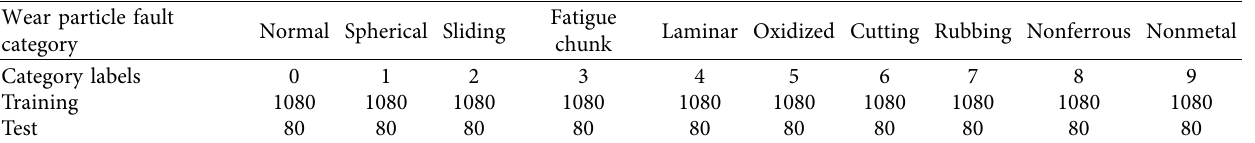
Figure 9: Feature visualization via t-SNE. Last hidden fully connected layer representation for the test samples in four models: (a) DCNN model; (b) fine-tuned pretrained VGG19 model; (c) fine-tuned pretrained GoogLeNet model; (d) LCNNE Table 1: Description of wear particle image datasets.